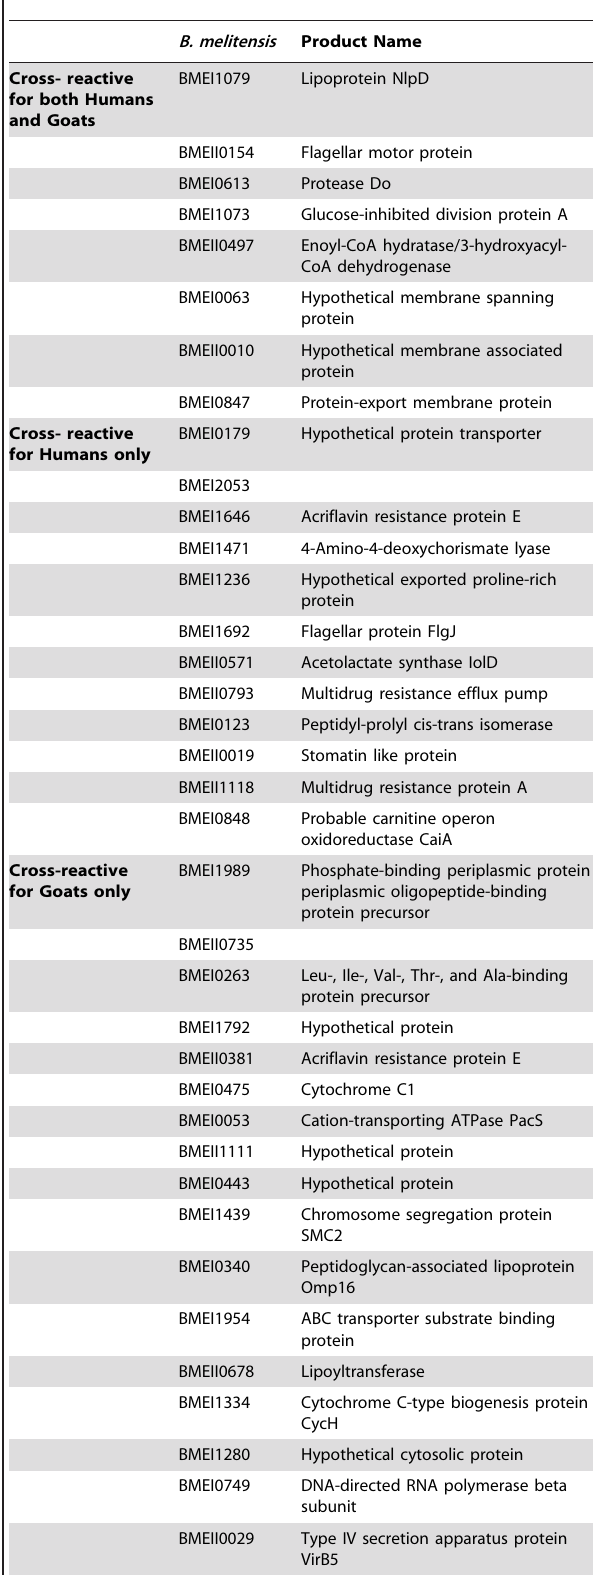
Table 2. Cross-reactive Brucella melitensis antigens for humans and goats.